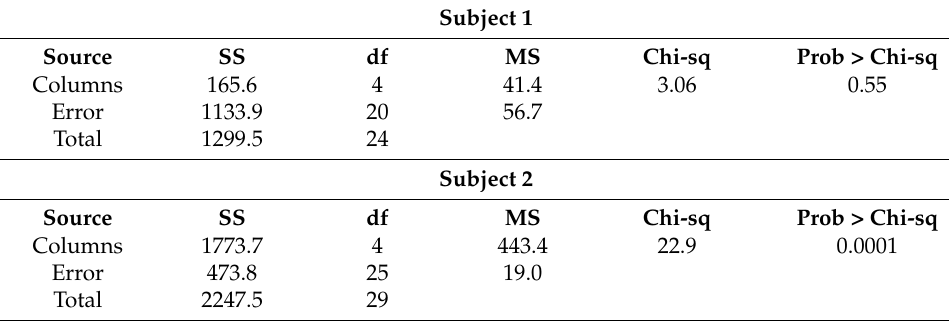
Table 3. Kruskal-Wallis ANOVA table for AUC at EIM.